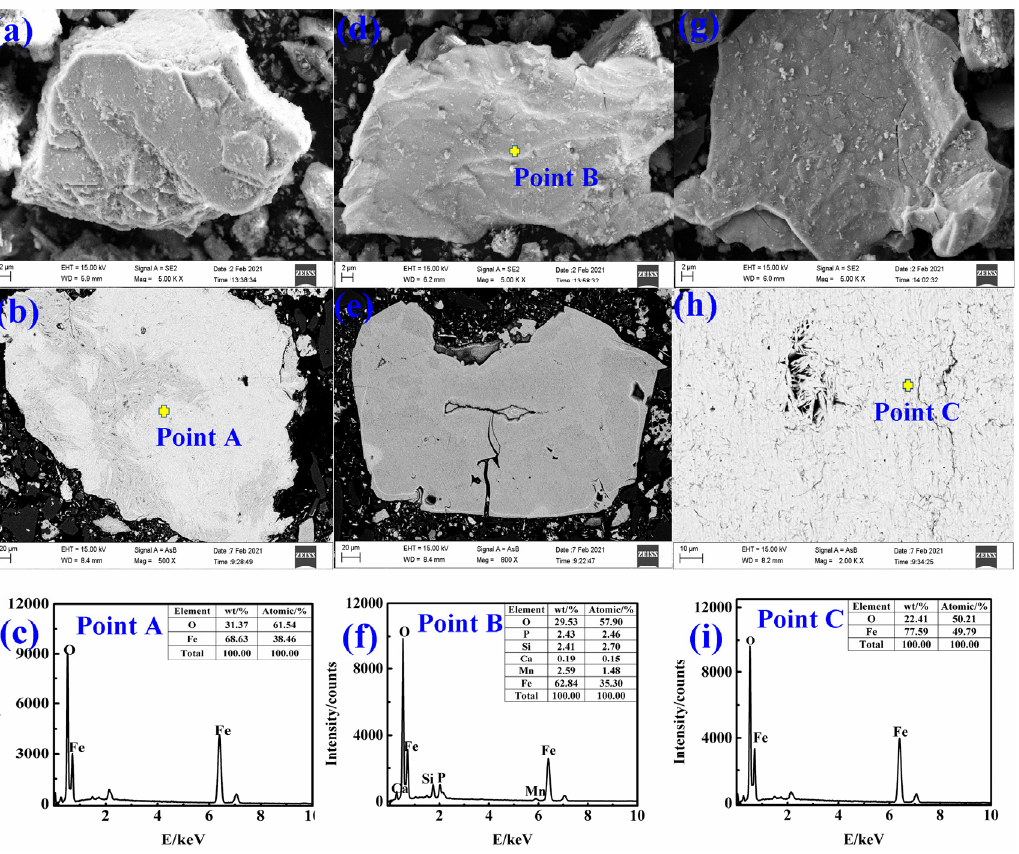
Figure 10. SEM–EDS analysis of raw ore and roasted products: ( a – c ) raw ore; ( d – f ) roasted product of 3 min; ( g – i ) roasted product of 12.5 min.